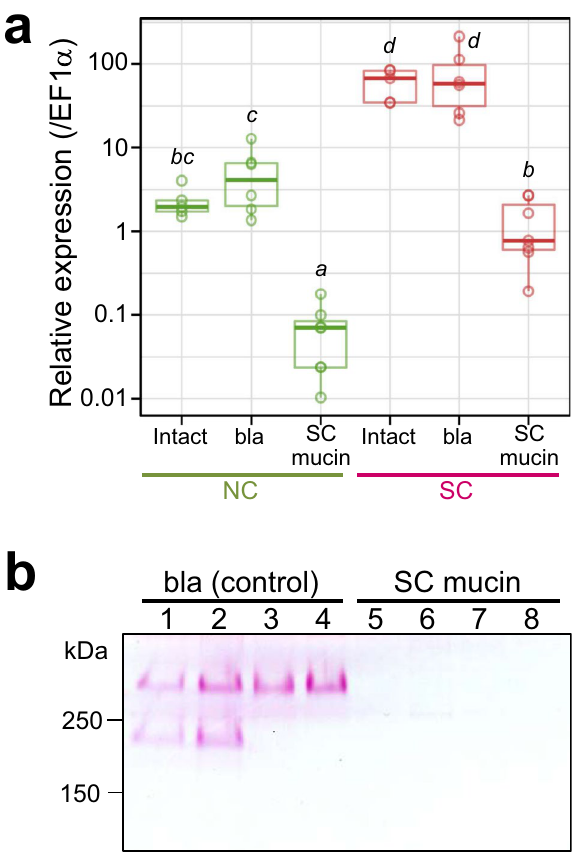
Figure 6. Suppression of SC mucin production by RNAi. ( a ) Suppression of SC mucin gene expression by RNAi. Adult females injected with dsRNA targeting β-lactamase gene (bla), those injected with dsRNA targeting SC mucin gene (SC mucin), and those without injection (Intact) were dissected 14 days after the treatment, and their normal crypts (NC) and swollen crypts (SC) were subjected to quantitative RT-PCR of SC mucin gene expression. Individual quantification values (circles, N = 5–7) are shown with box plots. Different alphabetical letters indicate statistically significant differences (likelihood ratio test for GLM, P < 0.05). ( b ) Depletion of SC mucin protein in the swollen crypts after RNAi. Adult females 14 days after the treatment were dissected and subjected to SDS-PAGE followed by PAS staining. Lane 1–4 and lanes 5–8 represent different individuals,